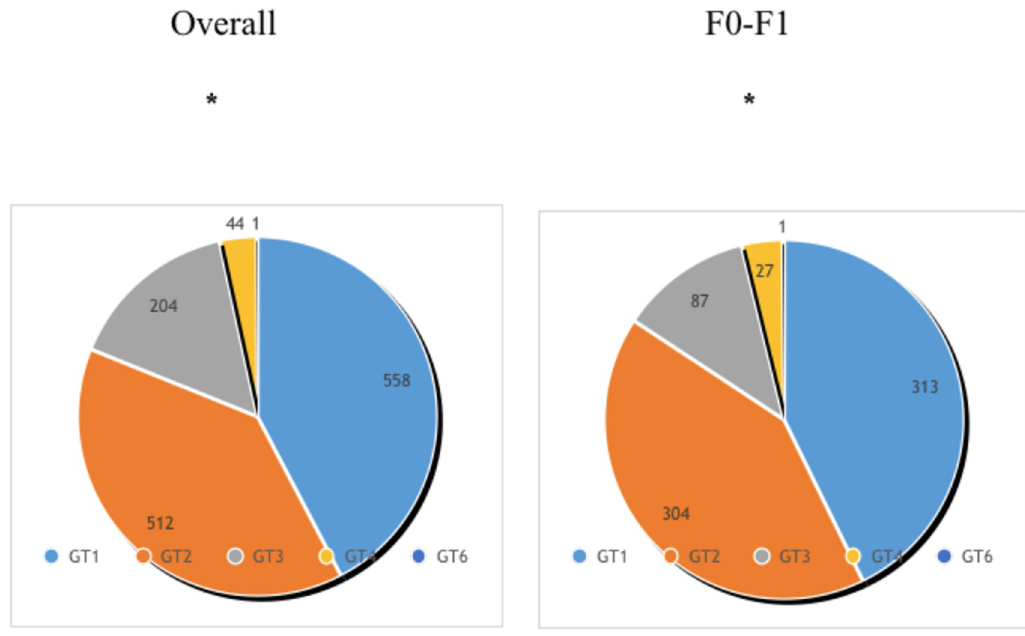
Fig 1. HCV genotype distribution overall and by F0/F1. The figure demonstrates that all the genotypes but GT5 are represented in this real world cohort. GT1 and GT2 were the most frequent accounting for 42% and 39% respectively. This proportion was maintained when 732 patients with F0-F1 stage of fibrosis were analyzed separately (42.7% were GT1 and 41.5%